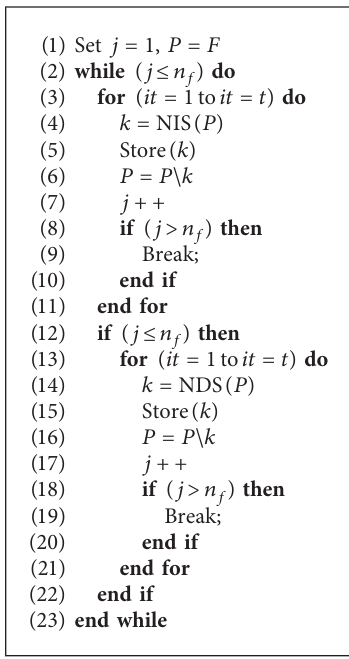
A LGORITHM 3: 2-swapping algorithm: SIDA